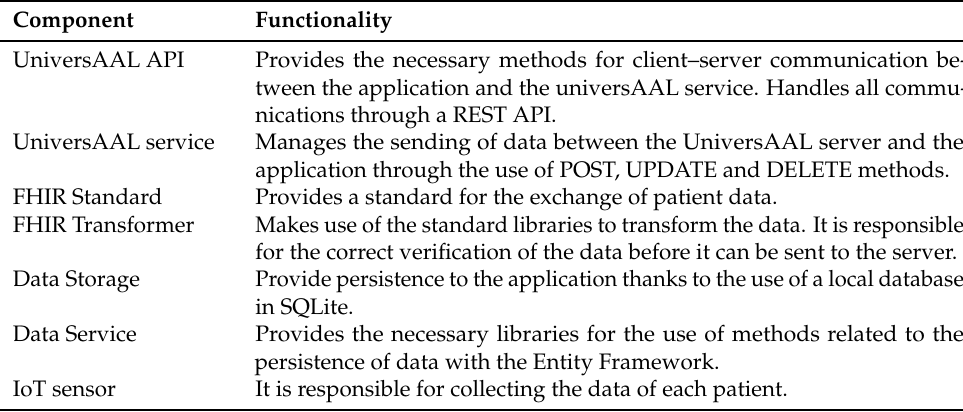
Figure 4. Logic diagram of the system components. Table 3. Summary of the main components used in the